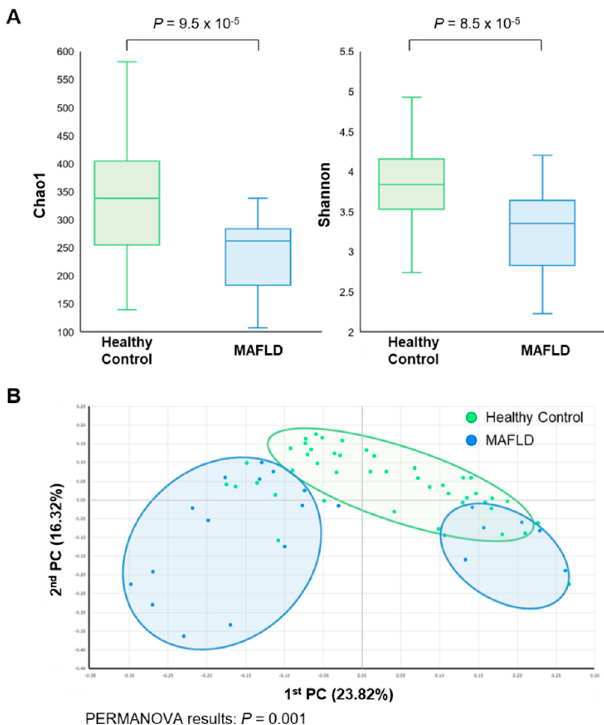
Figure 1. Comparison of microbial composition between metabolic associated fatty liver disease (MAFLD) patients and healthy controls. ( A ) Alpha diversity (Chao1 and Shannon’s index), ( B ) Beta-diversity (permutational multivariate analysis of variance).